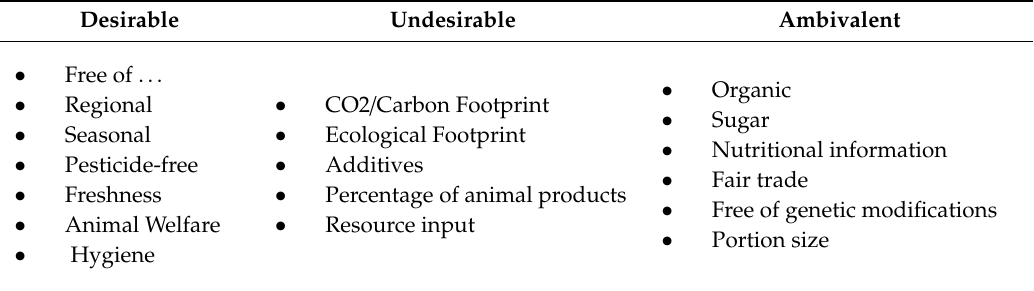
Table 3. Desirable and undesirable sustainability aspects in out-of-home catering (OOHC) (focus group).